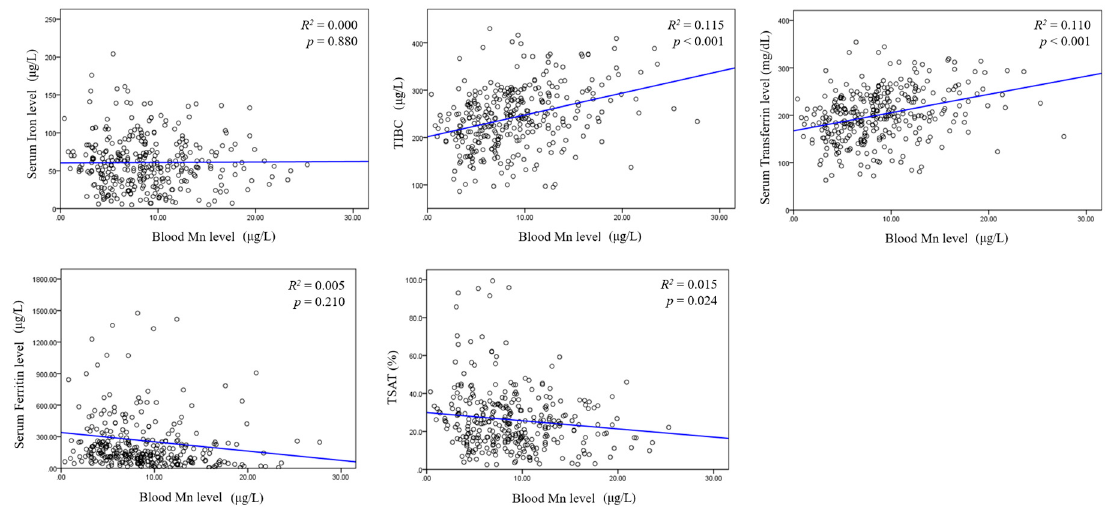
Figure 4. Blood Mn and various anemia markers.